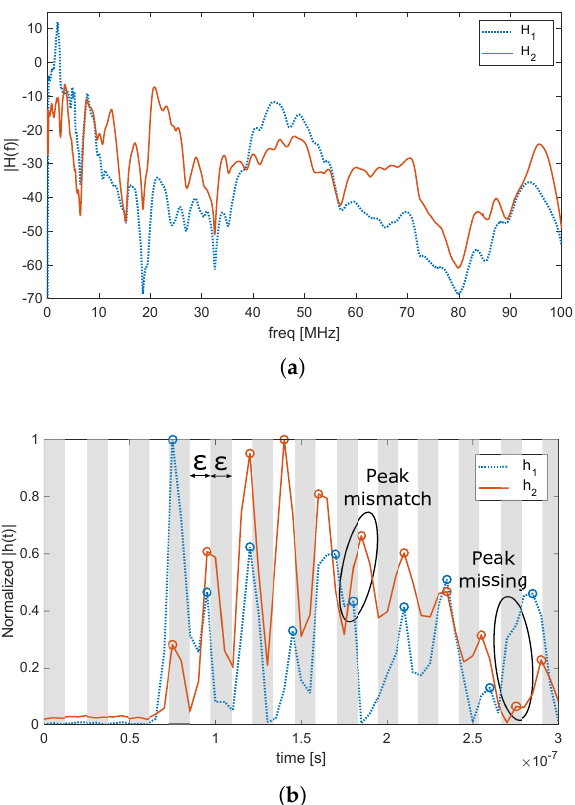
Figure 5. Example of a power line communication (PLC) channel transfer function in the two directions, in the frequency ( a ) and time ( b )